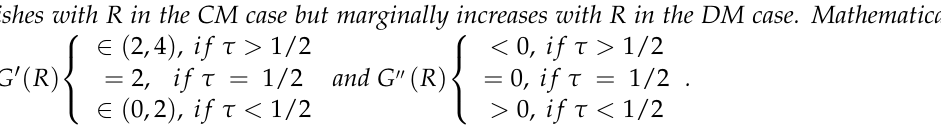
Figure 3. The effects of consumer mobility on the market outcomes: ( a ) the effect on price; ( b ) the effect on advertising level; ( c ) the effect on demand; ( d ) the effect on profit; ( e ) the effect on consumer surplus; and ( f ) the effect on social welfare. Lemma 2. The number of effective consumers in the CM (DM) case increases (decreases) with AMD, i.e.,